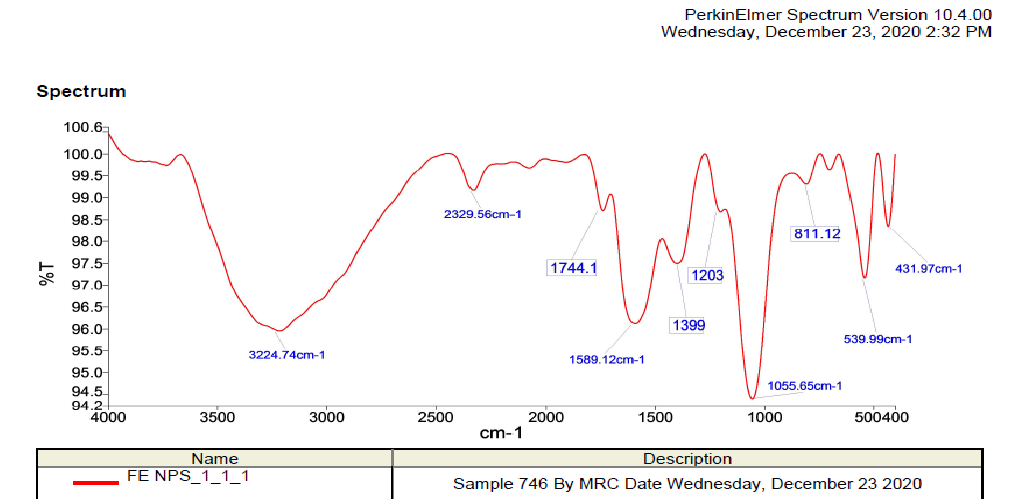
Fig. 6. FTIR spectrum of